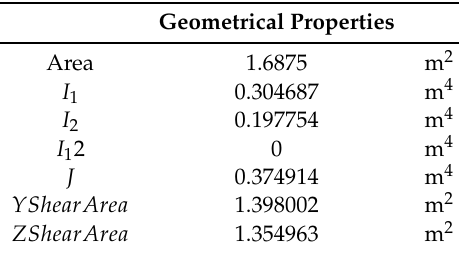
Table 2. Winglet Beam Characteristics.